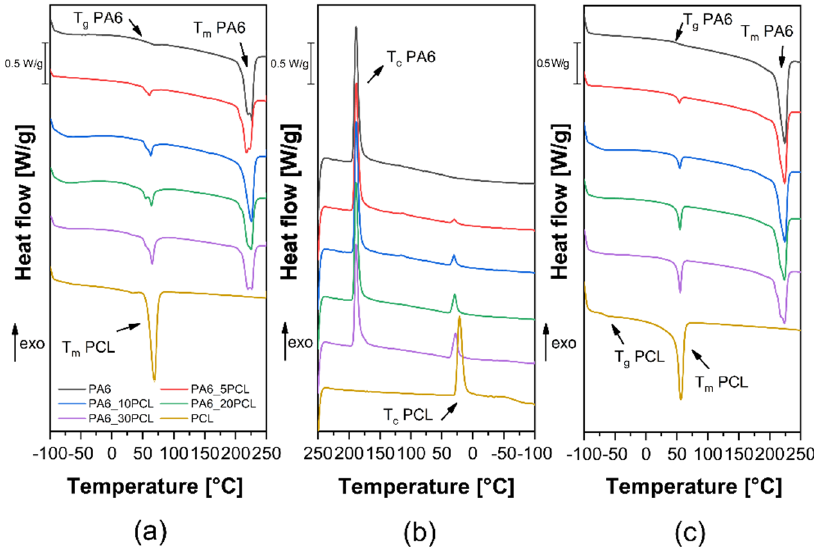
Figure 7. DSC thermograms of the produced PA6/PCL blends. ( a ) First heating scan, ( b ) cooling scan, ( c ) second heating scan. Table 1. Results of the DSC tests on the prepared PA6/PCL blends.